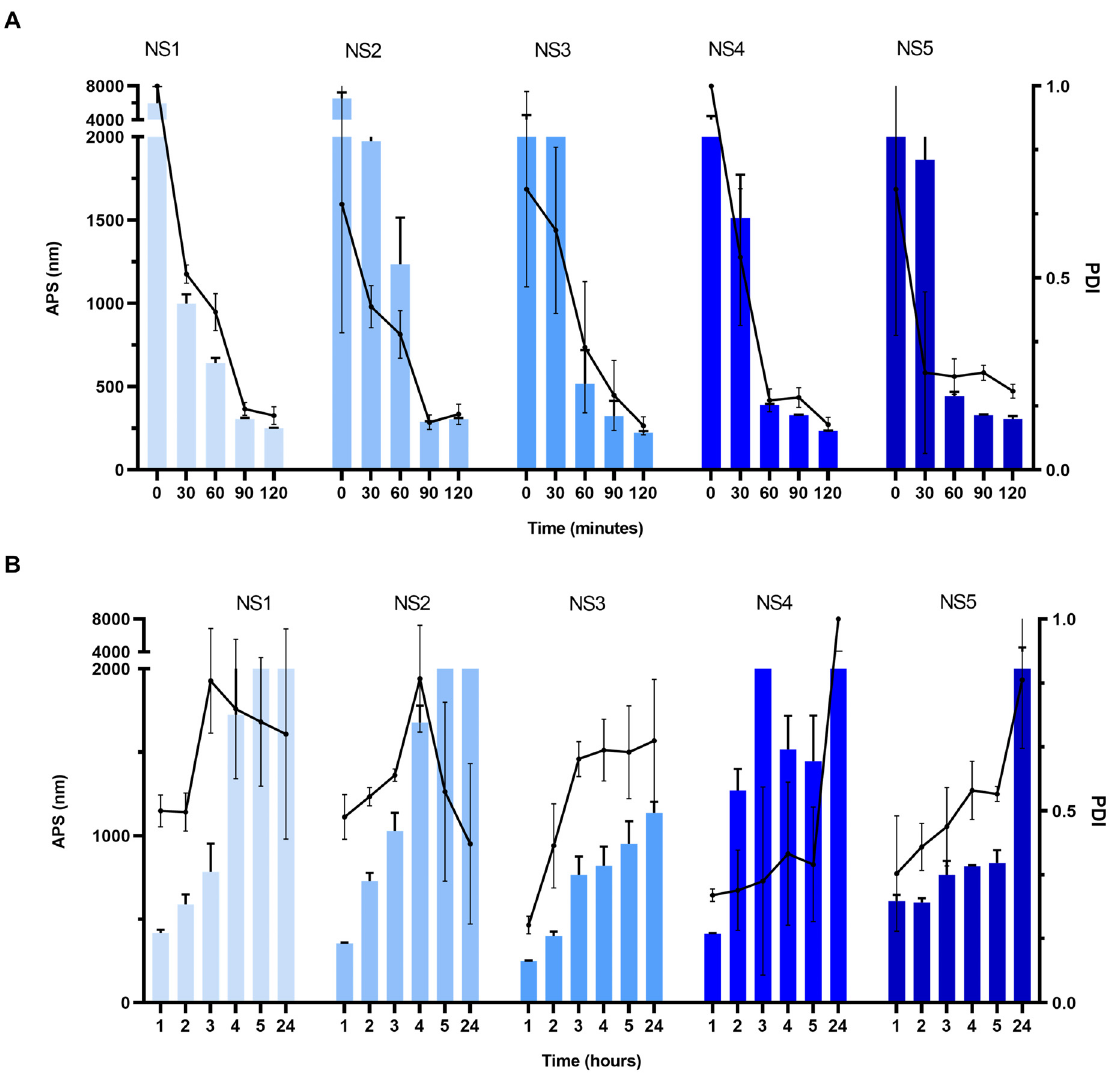
Figure 1. Average particle size (APS) and polydispersity index (PDI) of different drug nanosuspension from mixture design ( A ) during the wet milling process and ( B ) after the wet milling process at room temperature. Results are presented as means ± SD ( n = 3) for all tested drug nanosuspen- sions.